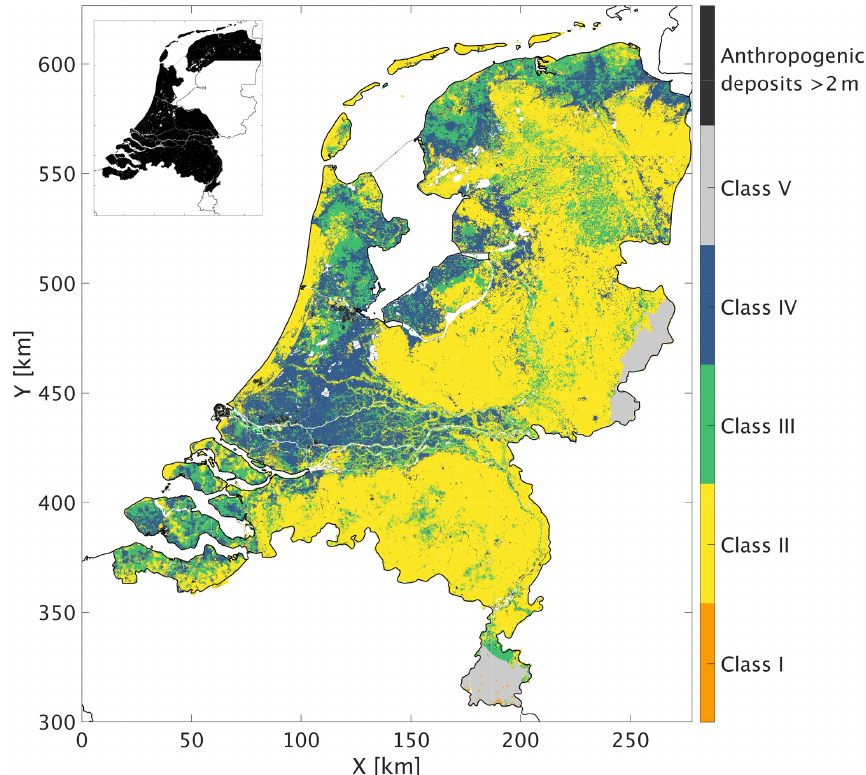
Figure 12. Seismic site-response zonation map for the Netherlands designed for low-magnitude induced earthquakes. The GeoTOP model coverage is highlighted in black in the small inset. For the remaining part of the Netherlands, the NL3D model is used as the foundation for the classification. The white spots are water bodies. The amplification factors and related uncertainties are presented in Table